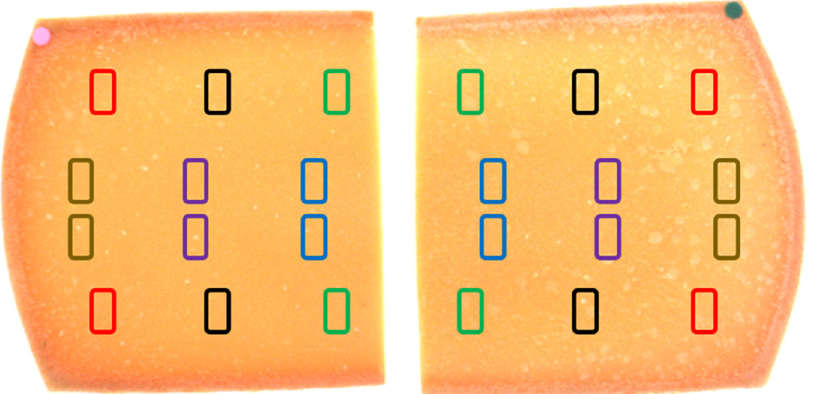
Figure 1. Example of two slices of Trentingrana cheese. Each box corresponds to one sampling position, each color to a sampling zone: round (RND, red); round central (RNDs, brown); external plate (RNDp1, black); intermediate zone (Int, purple); internal plate (RNDp2, green); center (CNT, blue). Globally, 317 cheese wheels were sampled from 12 sampling sessions from each dairy